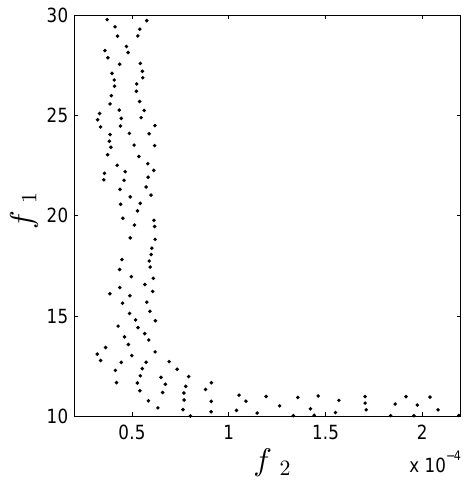
Figure 11. Approximation of P Q , (cid:101) obtained with N (cid:101) SGA